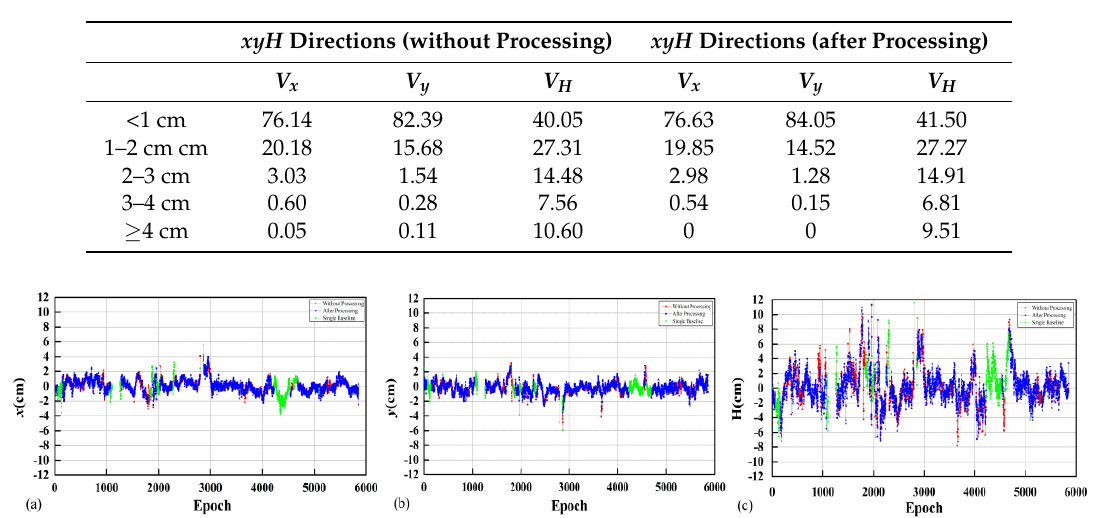
Figure 8. Differences in position in relation to the coordinate time series of the monitoring point: ( a ) x direction; ( b ) y direction; ( c ) H direction. The standard deviations (STDs) of the background noises are ±5.0, ±4.5, and ±13.0 mm in the x , y , and H directions, respectively. It is evident that, after the filtering, the background noises are almost eliminated and the GNSS time-series becomes smoother. After filtering, the differences of 89.34% of the x coordinates and 95.08% of the y coordinates are within ±1.0 cm, while the differences of 95.24% of the H coordinates are within ±4.0 cm. In addition, the results show that the displacement in the x direction is slightly larger than the displacement in the y direction, which may be related to wind